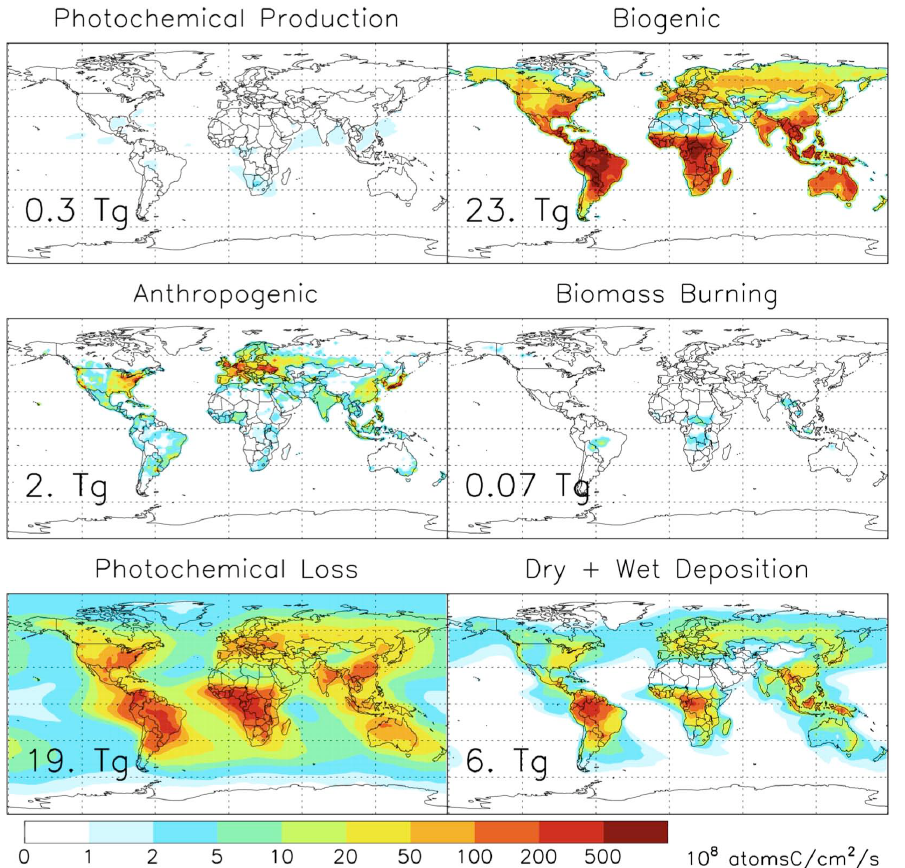
Fig. 2. Annual average sources and sinks of ethanol in GEOS-Chem. Shown are photochemical production, biogenic emissions from live and decaying plants, anthropogenic emissions (urban/industrial+biofuel), biomass burning emissions, photochemical loss, and